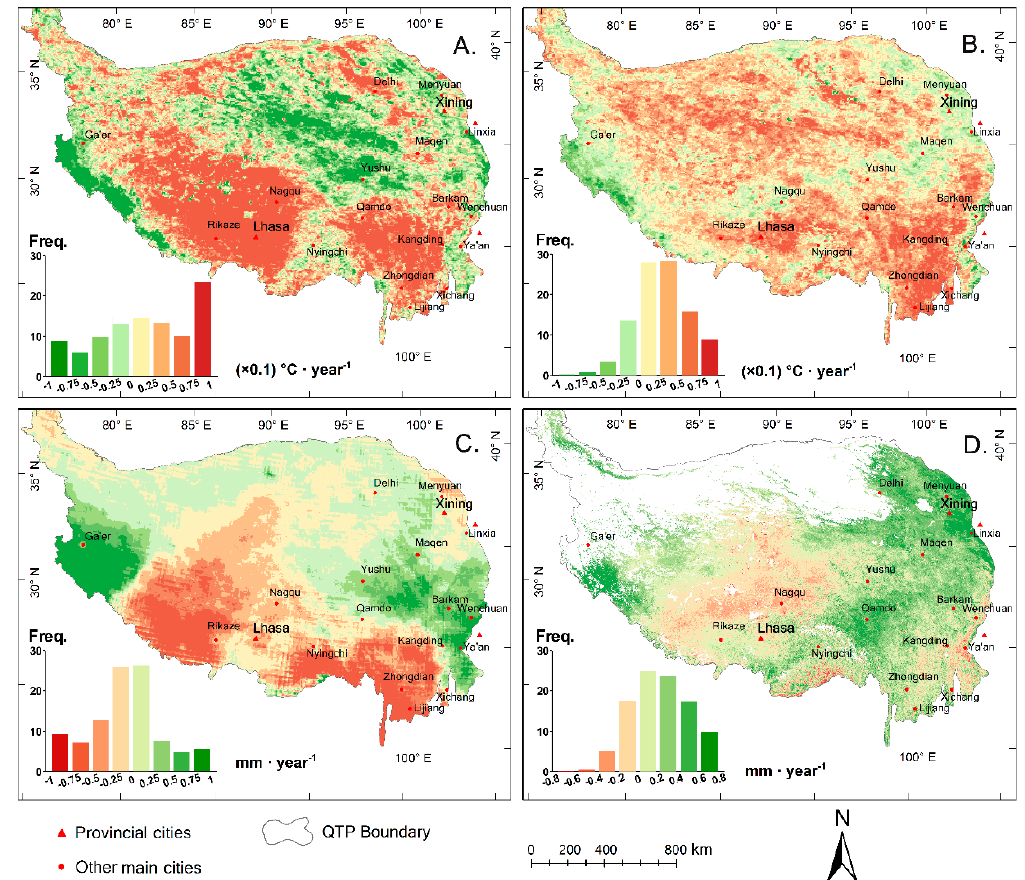
Figure 6. Spatial patterns of the trends of ( A ) annual mean land surface temperature at daytime, ( B ) annual mean land surface temperature at nighttime, ( C ) annual mean precipitation, and ( D ) annual mean evapotranspiration in 2001–2015 (maps and histograms were created using ArcMap 10.6). Conservation policies may also play an important role in shrubland and forest expansion in QTP.